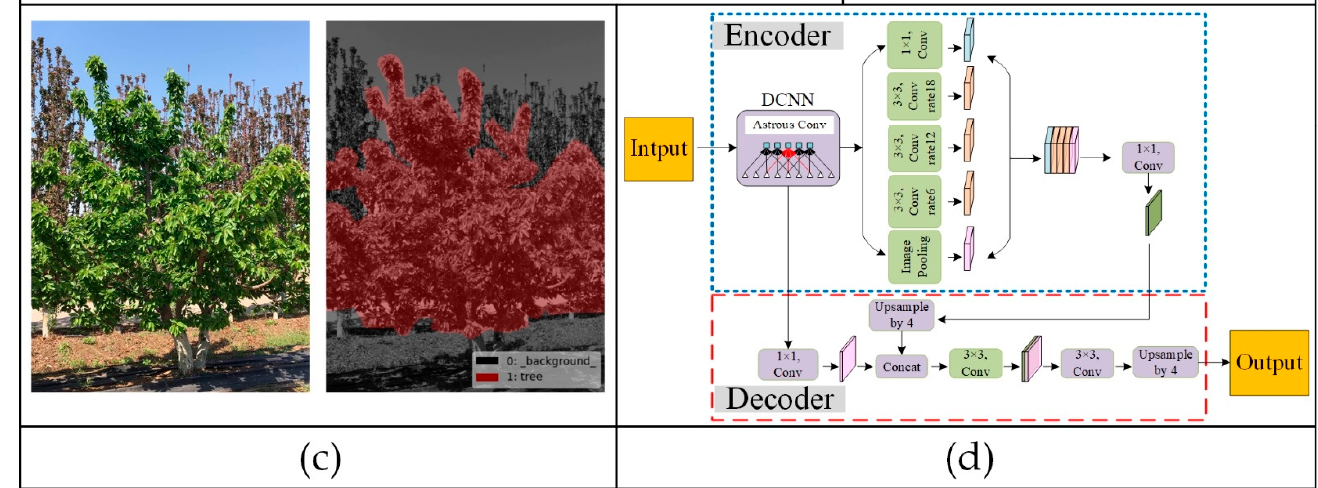
Figure 9. The illustrations of the four competing segmentation. ( a ) Relationship between k and SSE. ( b ) Image foreground labeling. ( c ) Labeled data for model training. ( d ) The structure of the DeepLabV3+ network.